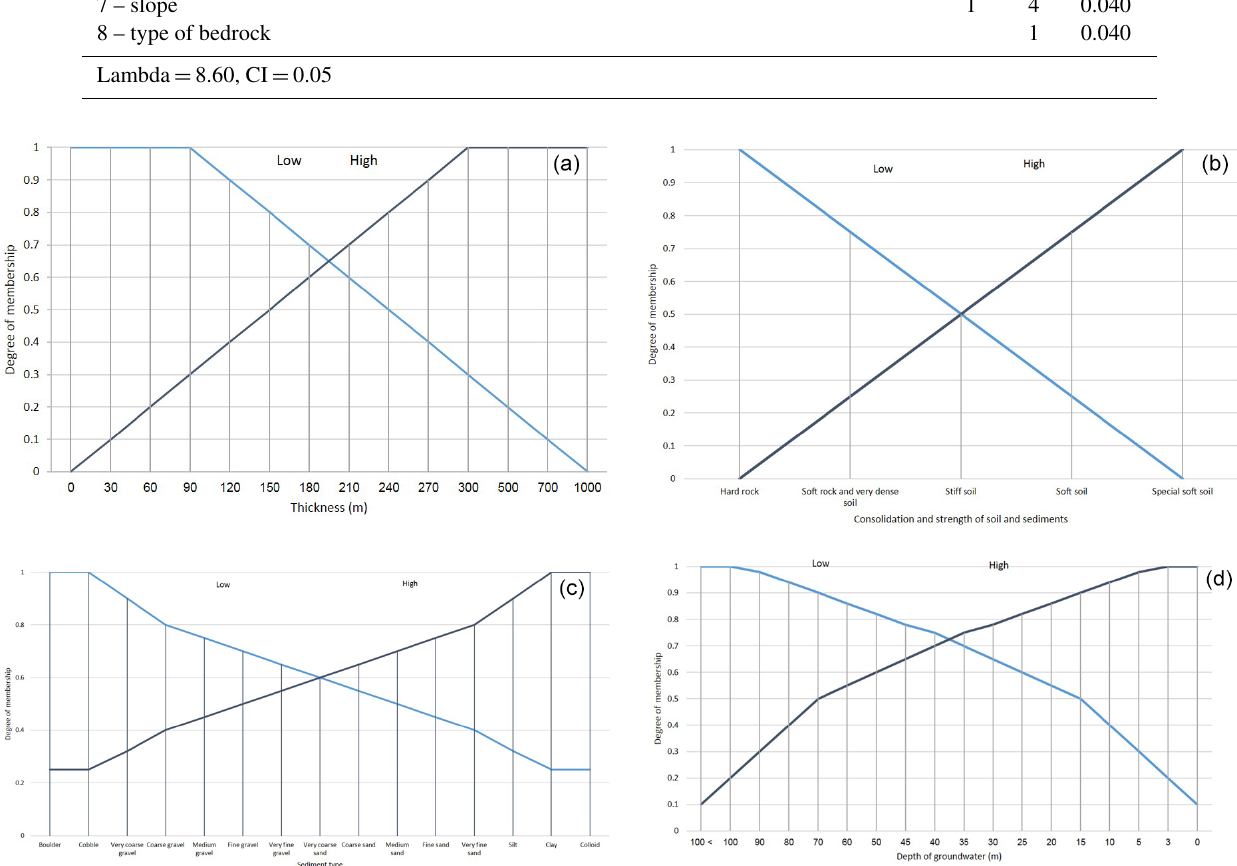
Figure 4. Membership functions (MFs) based on the fuzzy logic system: thickness of soil and sediments (a) , consolidation and strength of soil and sediments (b) , type of soil and particle size distribution of sediments (c) , depth of groundwater (d) .